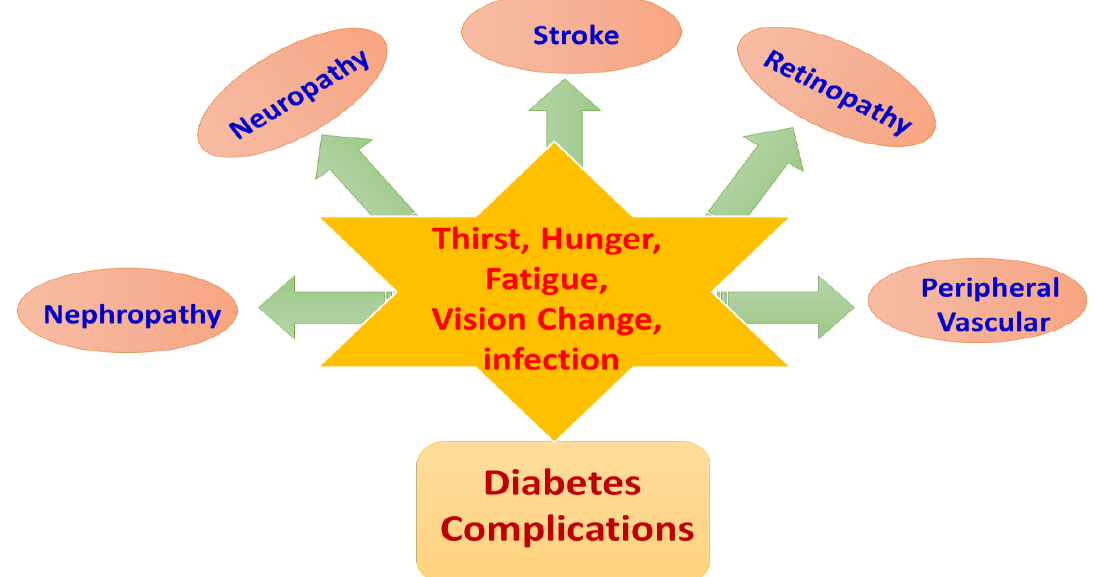
Figure 1. The symptoms of diabetic conditions and associated complications.